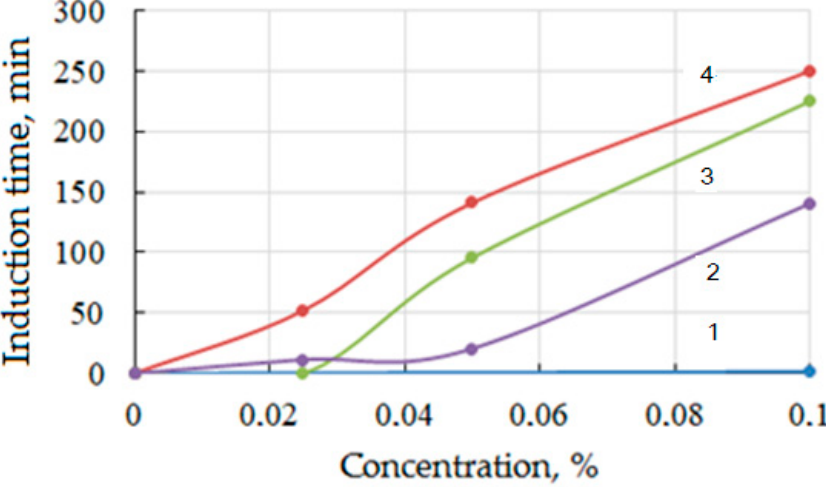
Figure 13. Dependence of induction time of hydrate formation on methanol concentration (1) and mono- (2), di- (3), and triethanolammonium salts of carboxymethylcellulose (4).